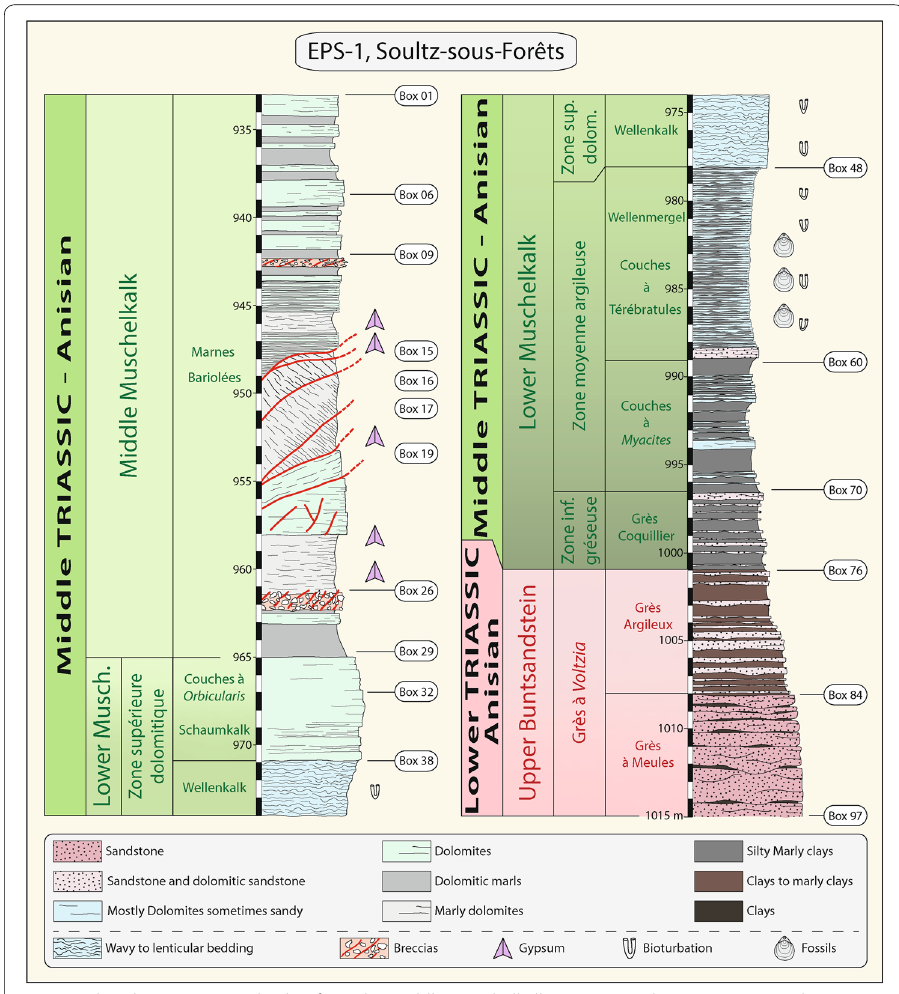
Fig. 2 Litho-chronostratigraphic log from the middle Muschelkalk (Anisian) to the upper Buntsandstein (Anisian), issued from the EPS-1 core analysis. This log presents from top to base the Marnes Bariolées, the Couches à Myophoria Orbicularis , the Schaumkalk, the Wellenkalk, the Wellenmergel, the Couches à Térébratules, the Couches à Myacites, the Grès Coquillier and the Grès à Voltzia facies observed on the cores. At the right of the log column, the occurence of gypsum, fossils and bioturbations is indicated. The cores are stored in boxes of 1-m-length; in the figure their labels are indicated. The number 01 corresponds to the top of the coring (middle Muschelkalk), as the number 542 the transition between the Permian and the granitic Variscan basement (not represented on this log which shows only the cores from top of the